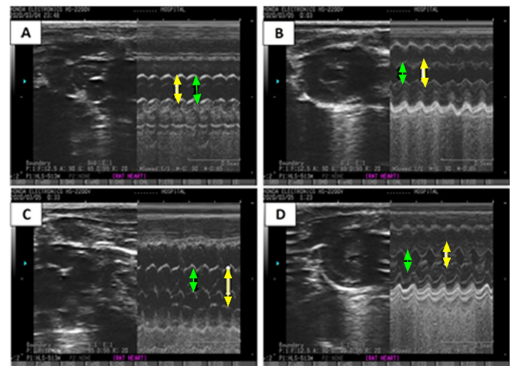
Figure 4. ECHO images demonstrate the effect of CCrP on ISO-induced changes in M-mode in LVEDD (yellow arrow) and LVESD (green arrow). Groups include saline/control ( A ), CCrP/control ( B ), ISO/saline ( C ), and ISO + CCrP ( D ). CCrP at a dose of 0.8 g/kg/day. ISO: isoproterenol; CCrP: cyclocreatine phosphate; LVEDD: left ventricular end-diastolic diameter; and LVESD: left ventricular end-systolic diameter.